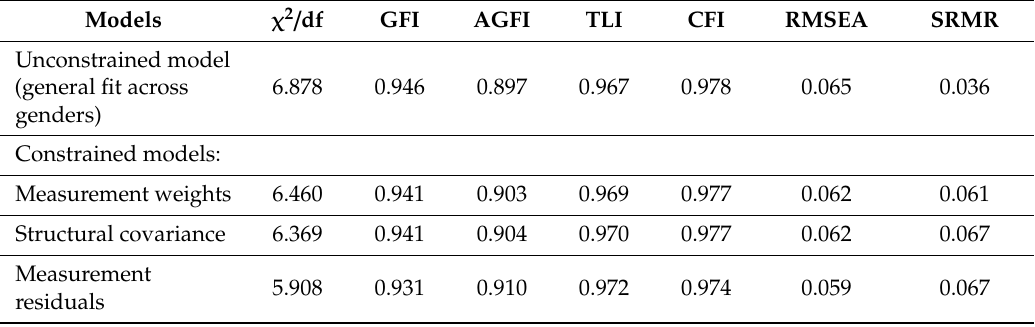
Table 3. Lithuanian Body Appreciation Scale-2 confirmatory factor analysis and structural invariance testing across genders from the second split-half adolescent subsample ( n =